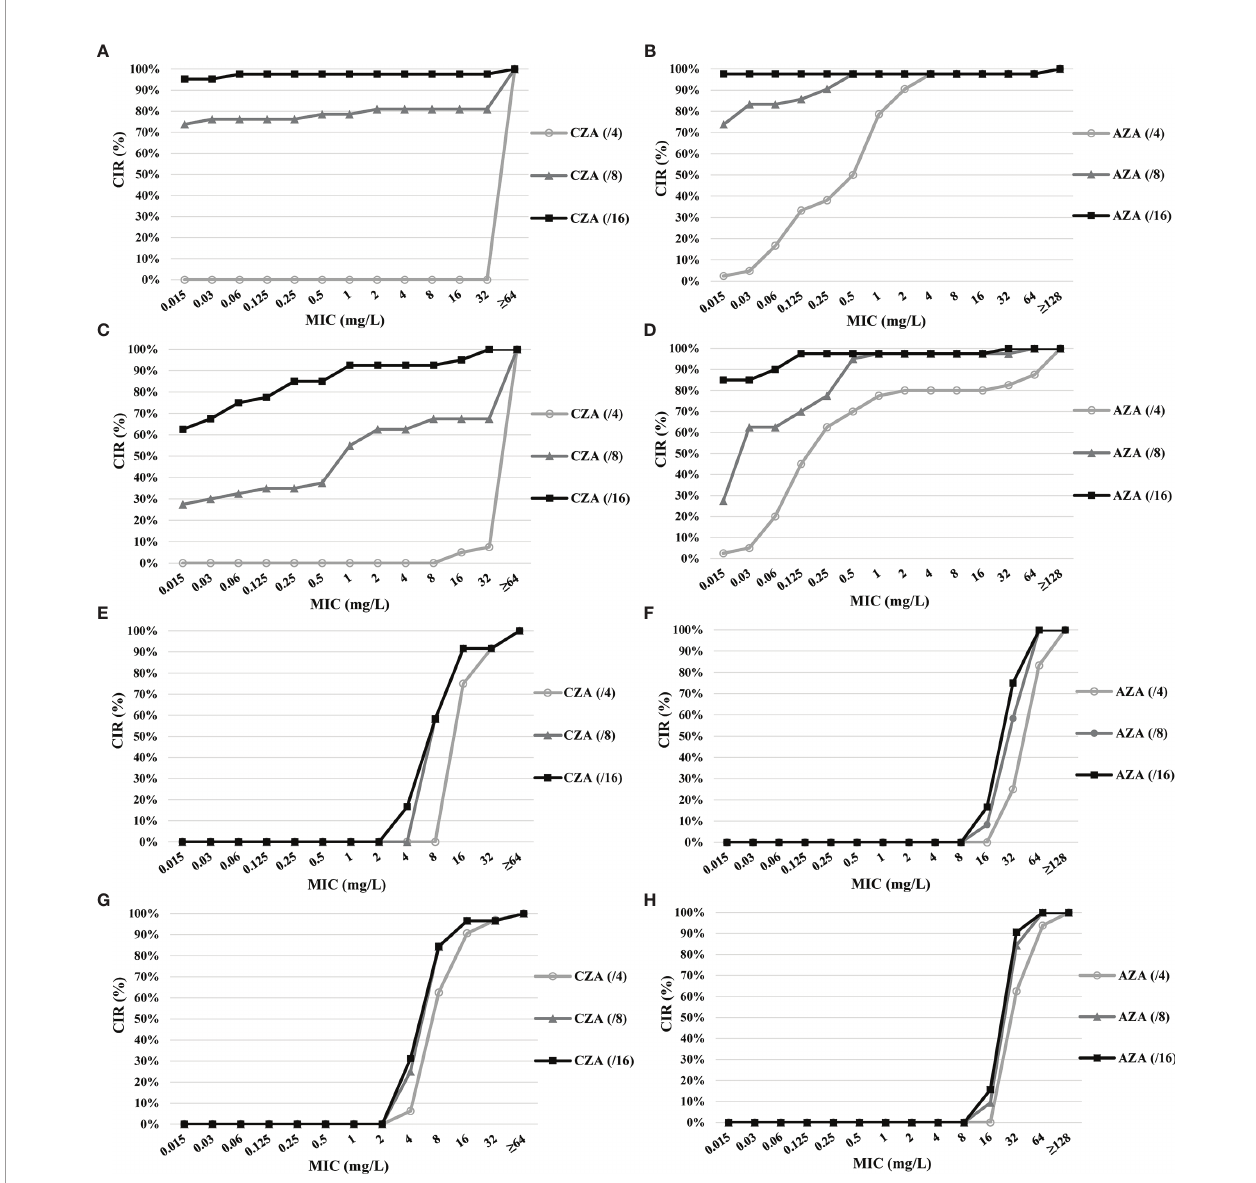
FIGURE 2 | Cumulative inhibition ratios (CIRs) of ceftazidime (CAZ) and aztreonam (ATM) with increased avibactam concentration against ceftazidime – avibactam (CZA)- resistant carbapenem-resistant organisms (CROs) and carbapenem-resistant Pseudomonas aeruginosa (CR-Pae) with a high-level minimum inhibitory concentration (MIC) of aztreonam – avibactam (AZA). (A) CZA against CZA-resistant carbapenem-resistant Escherichia coli (CR-Eco). (B) AZA against CZA-resistant CR-Eco. (C) CZA against CZA-resistant carbapenem-resistant Klebsiella pneumoniae (CR-Kpn). (D) AZA against CZA-resistant CR-Kpn. (E) CZA against CZA-resistant CR-Pae. (F) AZA against CZA-resistant CR-Pae. (G) CZA against CR-Pae with the high-level MIC of AZA. (H) AZA against CR-Pae with the high-level MIC of